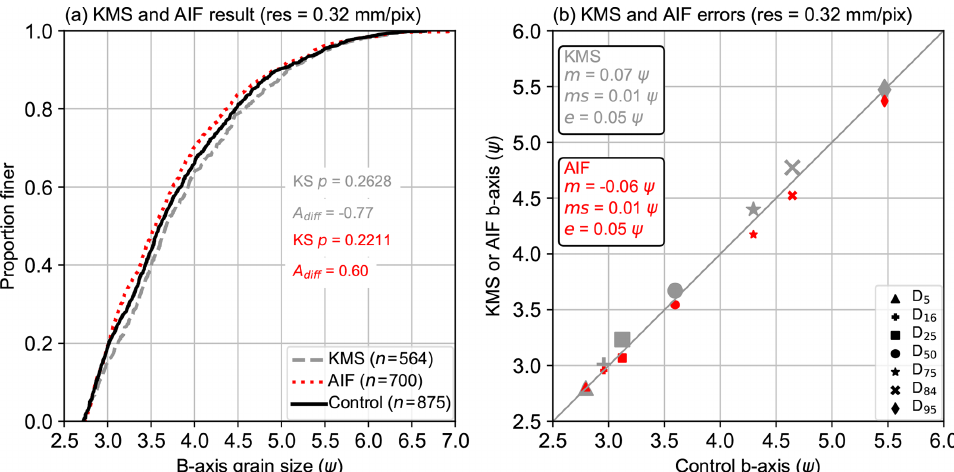
Figure 13. (a) Results from hand-clicked control (black line), KMS PebbleCounts (gray, dashed line), and AIF PebbleCountsAuto (red, dotted line) from the 20-pixel truncated run on the 0.32mmpixel − 1 handheld imagery. In corresponding colors are the p -value results of a KS test and the A diff approximate integral between the curves for each approach versus the control data. (b) Percentile comparison for both methods with KMS in gray and AIF in red, with inset box showing the uncertainties for each in the corresponding color.